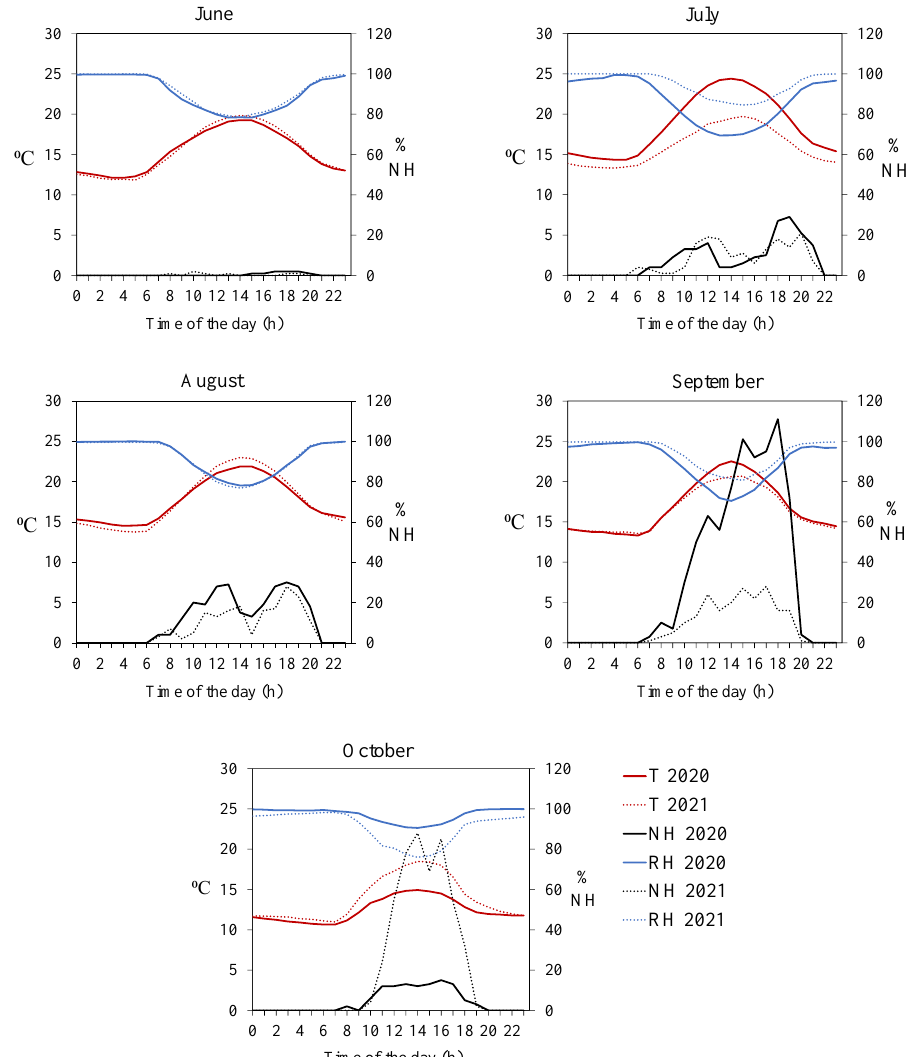
Figure 3. V. velutina sightings (NH), external temperature (T), and external relative humidity (RH) in the months with the highest pressure of hornets in front of the colonies: June, July, August, September, and October of both years (2020 and